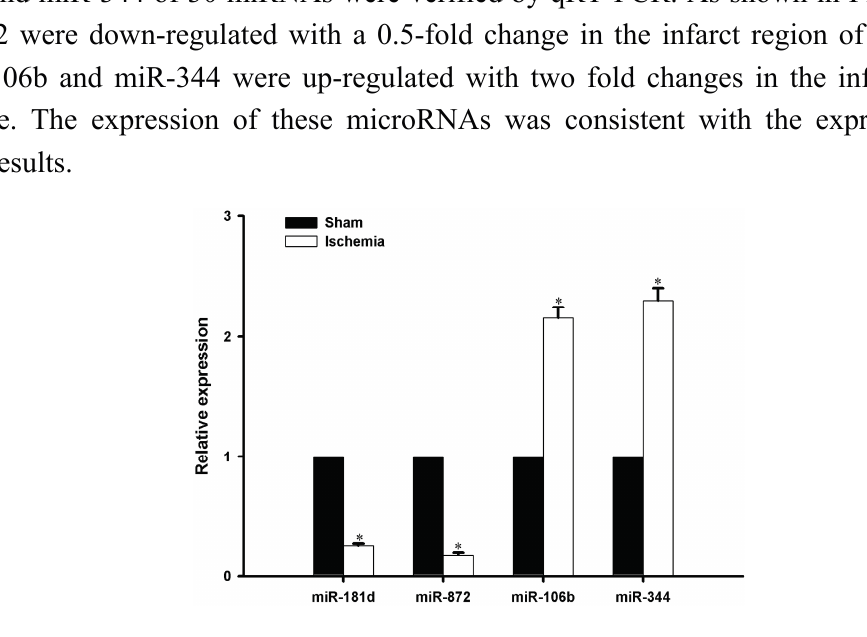
Figure 4. Gene expressions of four specified miRNAs are confirmed by real time RT-PCR. Each corresponding control of the verified miRNA with change is normalized as 1. Each test was in triplicates and U6 was used as internal control. The bars represent the mean ± SE, and n = 6 per group. * p <